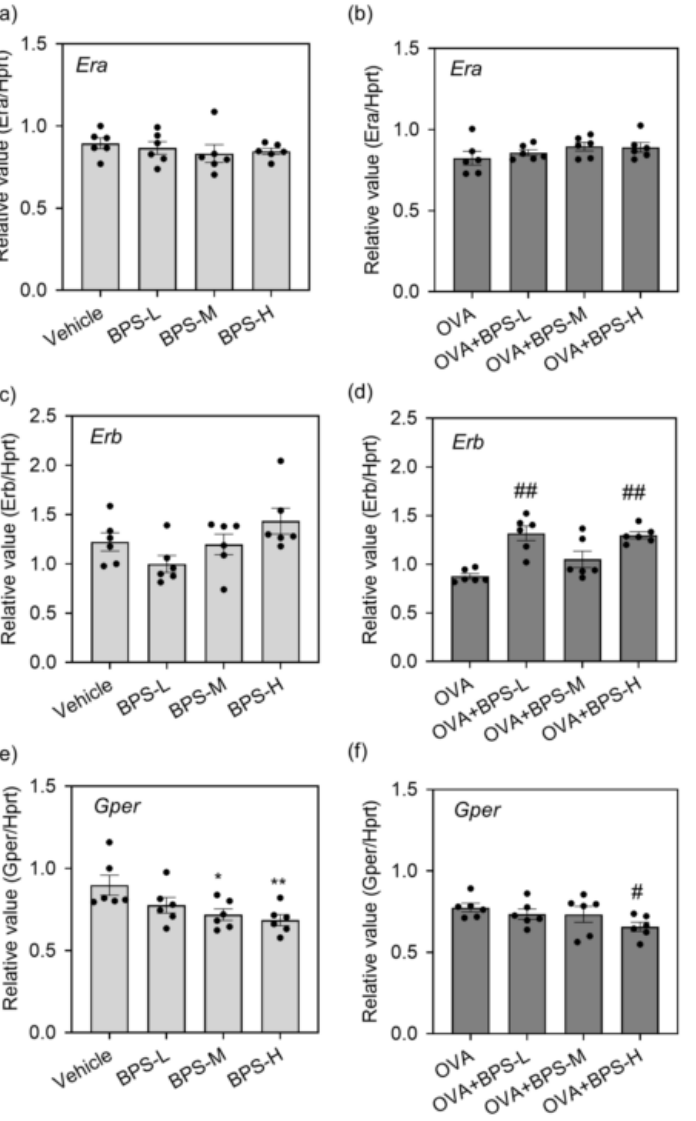
Figure 7. Gene expression of estrogen receptors in the lung. mRNA levels were analyzed 48 h after the last intratracheal administration by reverse transcription polymerase chain reaction. ( a , b ) Era . ( c , d ) Erb . ( e , f ) Gper . Data are expressed as mean ± SE for 5–6 animals per group. The relative intensity was normalized to housekeeping gene ( Hprt1 ). * p < 0.05 vs. Vehicle group, ** p < 0.01 vs. Vehicle group, # p < 0.05 vs. OVA group, ## p < 0.01 vs. OVA group. OVA, ovalbumin; SE, standard